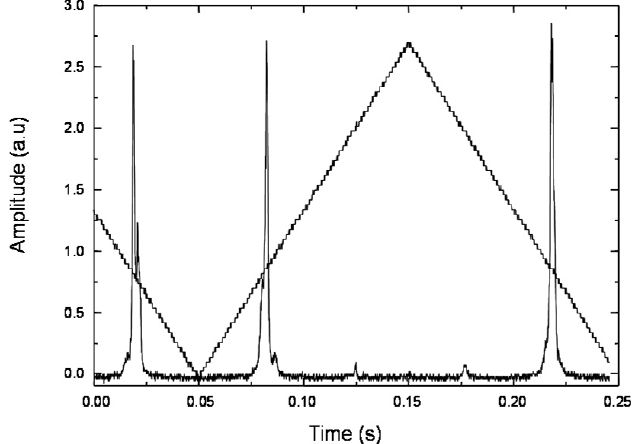
Fig. 8. Output of the scanning confocal Fabry P´erot analyser showing a single-frequency operation of the linear cavity laser at λ 2 ω = 656